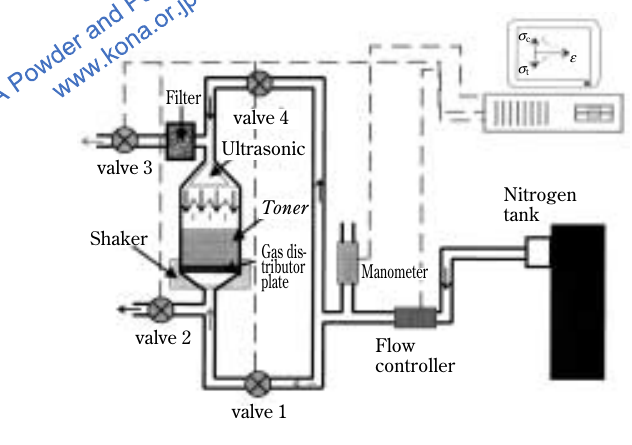
Schematic diagram of the automated Powder Tester. The powder sample is held in a 4.45-cm diameter, 17-cm high cylinder made of polycarbonate, the base of which is a sintered metal gas distributor of 5 µ m pore size. The cylinder is placed on a shaker used to help powder flu- idization. Dry nitrogen is supplied from a tank of com- pressed gas and a mass flow controller is used to adjust the flow. The pressure drop across the bed is measured by a differential pressure transducer. A series of com- puter-controlled valves are used to control the gas flow path through the bed. The bed height is read from an ultrasonic sensor. All these components are connected to a computer by means of a data acquisition board. A filter is placed upstream of valve 3 to catch elutriated particles and prevent valve 3 from damage.